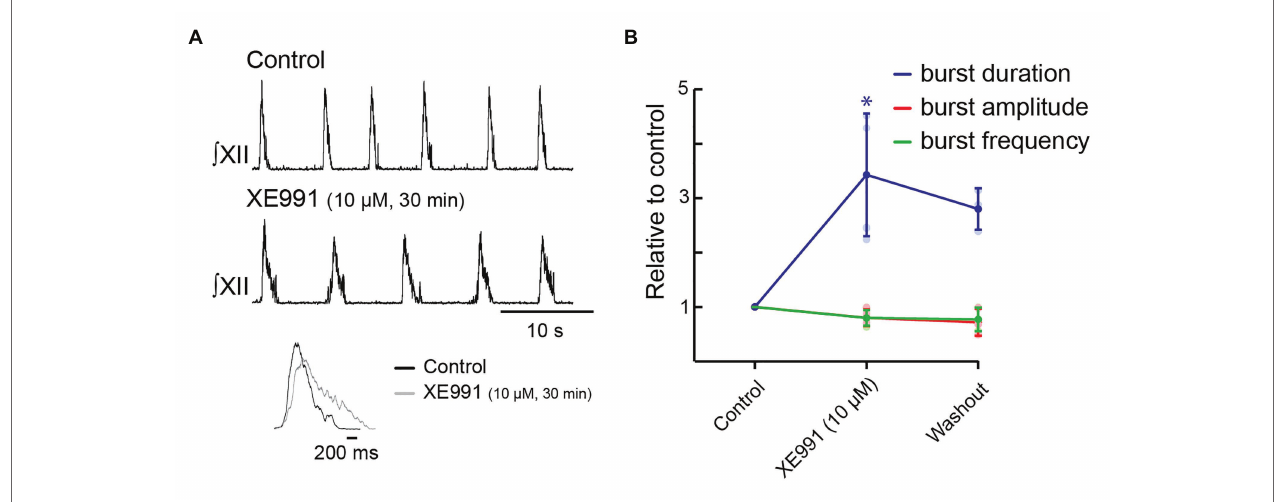
FIGURE 6 | Effects of blocking KCNQ channels with XE991 locally within pre-Bötzinger complex (preBötC) on inspiratory burst parameters in the rhythmic slice preparation. (A) Rectified, integrated recordings from XII nerve rootlets demonstrating inspiratory burst parameter changes in the presence of local application of XE991 as a series of 5-s pulses for 30 min. (B) Group data from XII nerve rootlet recordings when XE991 was applied locally within preBötC, n = 6 for control and 10 μ M of XE991 after 30 min, n = 4 washout. * p < 0.05, paired t